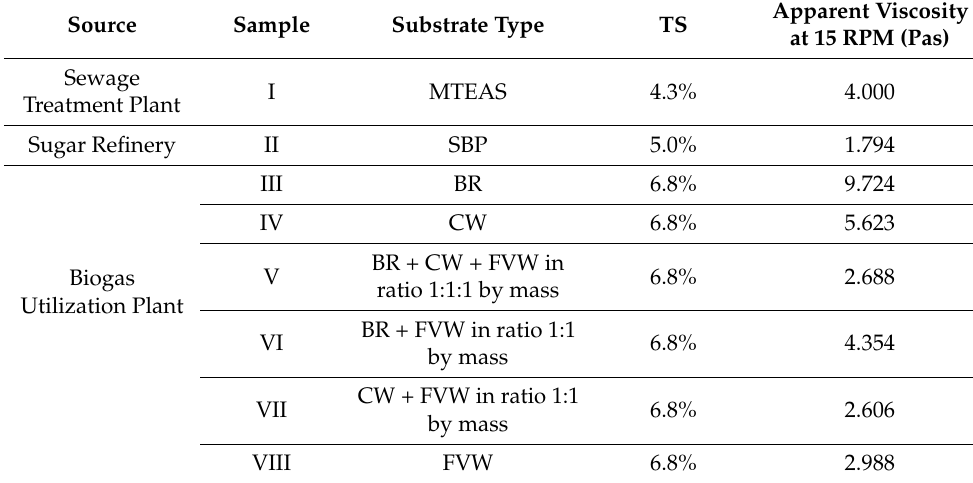
(BR), and the lowest for sample no. II (SBP), as presented in Table 5.